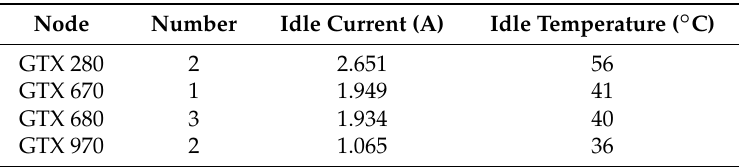
Table 4. GPU Cluster node configuration